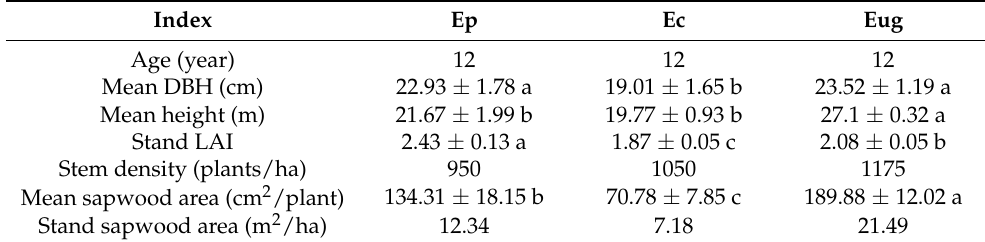
Table 1. Summary of the stand characteristics of the three experimental plantations of eucalyptus